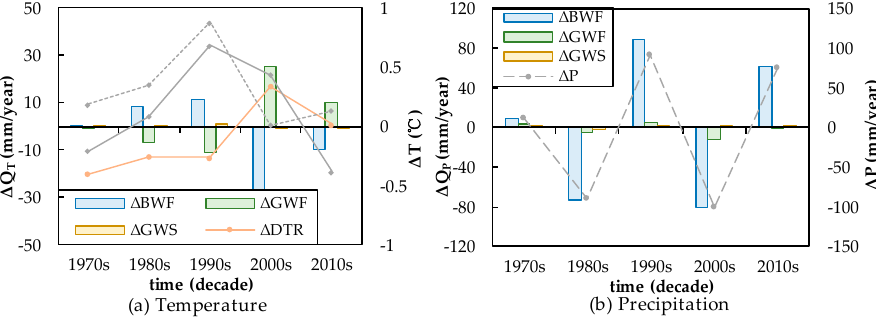
Figure 5. Changes in decadal hydrological components impacted by ( a ) temperature; ( b ) precipitation.